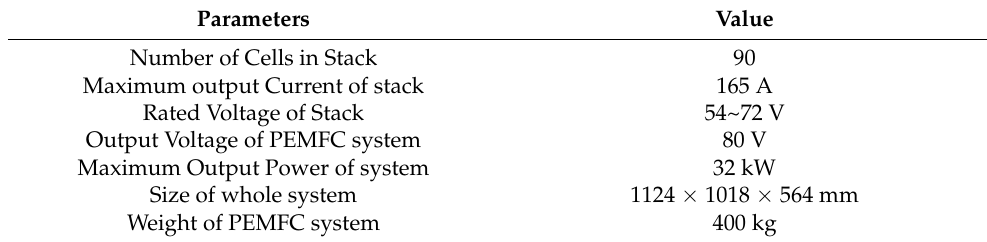
Table 1. Parameters of the PEMFC power system.